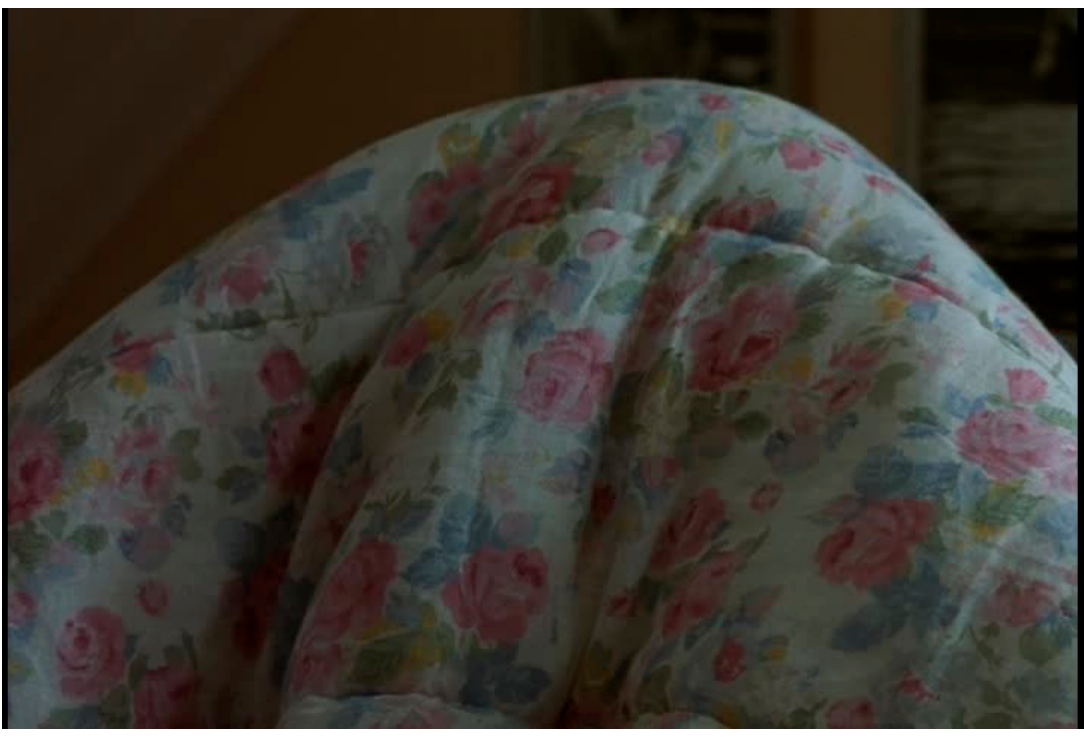
Figure 8. Isabelle emerges…